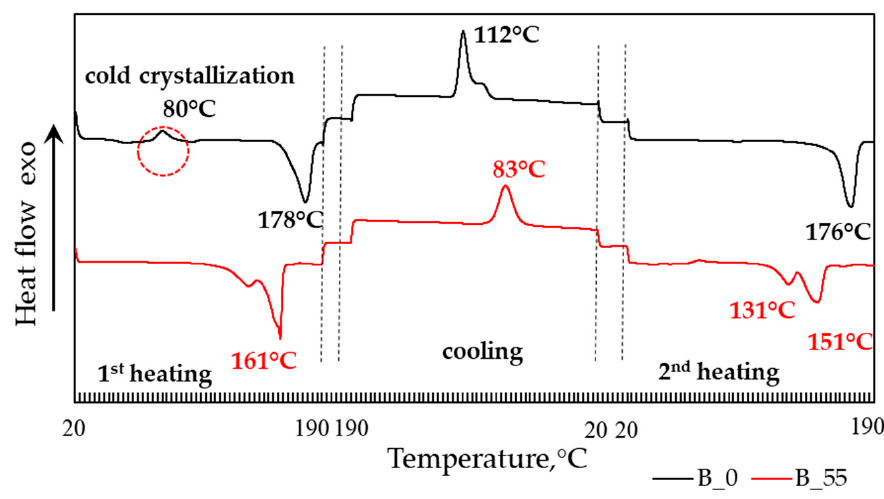
Figure 16. DSC curves of sample B before composting (B_0) and after 55 days of composting (B_55) in an electric composter.